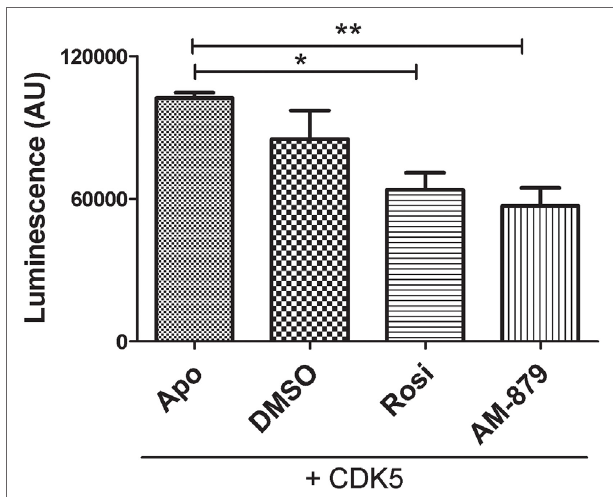
FigUre 6 | In vitro inhibition of cyclin-dependent kinase 5 (CDK5)-mediated phosphorylation of peroxisome proliferator-activated receptor gamma (PPAR γ ) by AM-879. Luminescence signal detected as consequence of ADP production in in vitro phosphorylation reaction containing CDK5/p35 kinase, ATP and PPAR γ ligand-binding domain (ADP-Glo ™ Kinase assay). Reactions were conducted in the absence (Apo) or the presence of threefold excess of Rosiglitazone (Rosi), AM-879 or dimethyl sulfoxide (DMSO). Data are the mean ± SEM ( n = 3, * p < 0.05, ** p < 0.01, vs